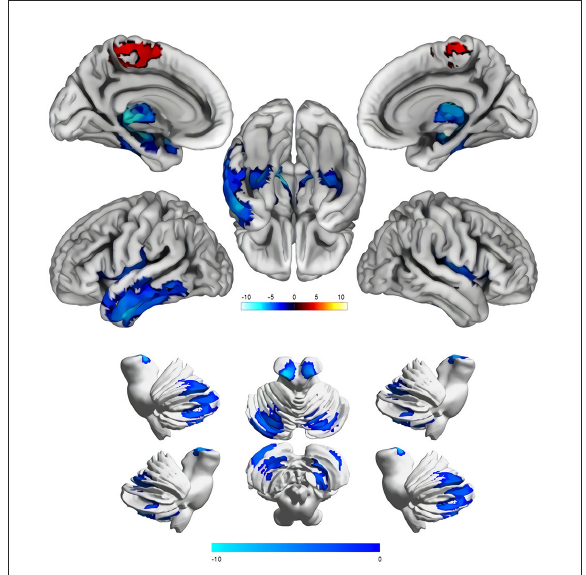
FIGURE3 Comparison results of the cerebral and cerebellar gray matter volume between the idiopathic normal-pressure hydrocephalus group and normal aging group (Cluster P < 0.05, Voxel P < 0.001, GRF corrected). Blue areas indicate reduced gray matter volume, and the red areas indicate increased gray matter volume. The color shade of the color bar represents the size of the T